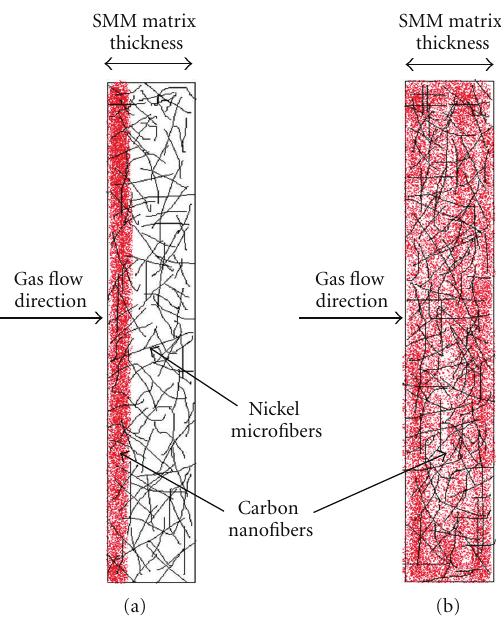
Figure 2: Side-view schematic diagram of sintered metal microfi- brous (SMM) matrix with (a) surface synthesis of CNF and (b) 3- dimensional synthesis of